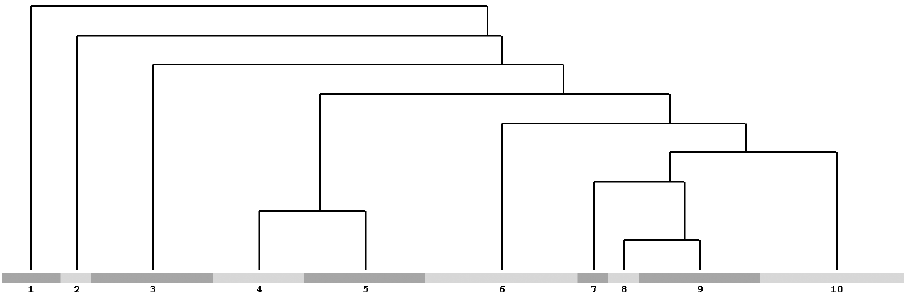
Figure 3. Hierarchical clustering resulting from Modified TWINSPAN analysis. Cluster 1) Fagus syl- vatica woodlands; 2) Amelanchier ovalis forest edges; 3) Saxifraga callosa chasmophytic vegetation; 4) Cynosurus cristatus hay meadows; 5) Bromopsis erecta montane grasslands; 6) Iris marsica community; 7) Rumex scutatus screes vegetation; 8) Paronychia kapela rocky outcrops vegetation; 9) upper-montane grass- lands, including also the Brachypodium genuense community and the Astragalus sempervirens community; 10) chamaephytes-rich dry